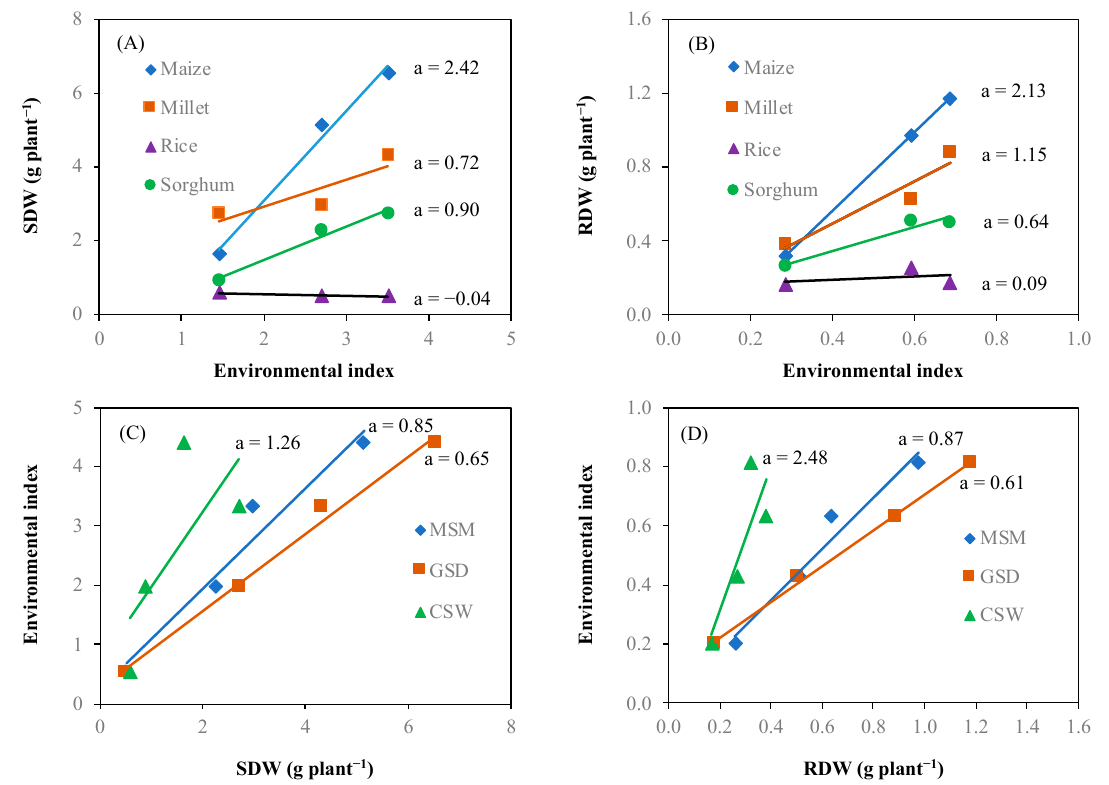
Figure 6. Interaction between the crop genotype and environment. Shoot dry weight (SDW) ( A ) and root dry weight (RDW) ( B ) of each crop (maize ( ◆ ), millet ( ■) , rice ( ▲ ), and sorghum ( ● )) responses to the environment, and environment (moderate soil moisture (MSM ( ◆ )), gradual soil drying (GSD ( ■)) , and continuous soil waterlogging (CSW ( ▲ )) effect on shoot dry weight (SDW) ( C ) and root dry weight (RDW) ( D ). Environmental index is mean value of SDW or RDW of different crop species under three different soil moisture statuses. a means regression coefficient of response.